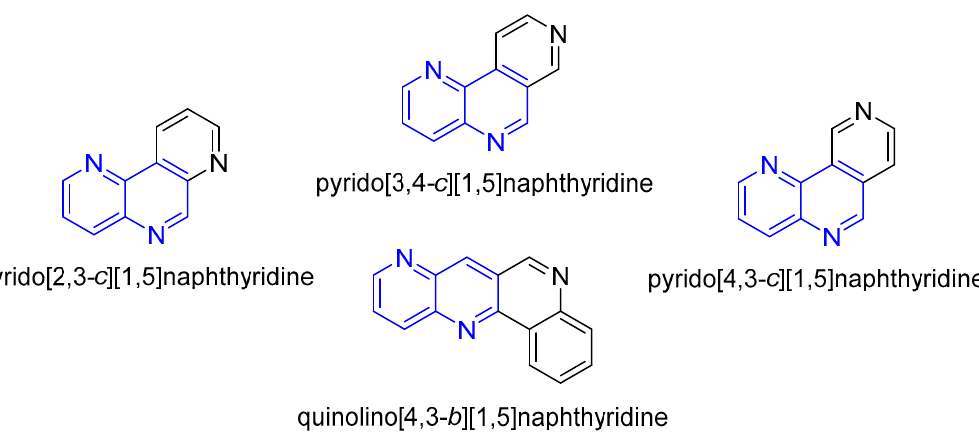
Figure 5. Examples of fused 1,5-naphthyridines with six-membered nitrogen heterocycles.